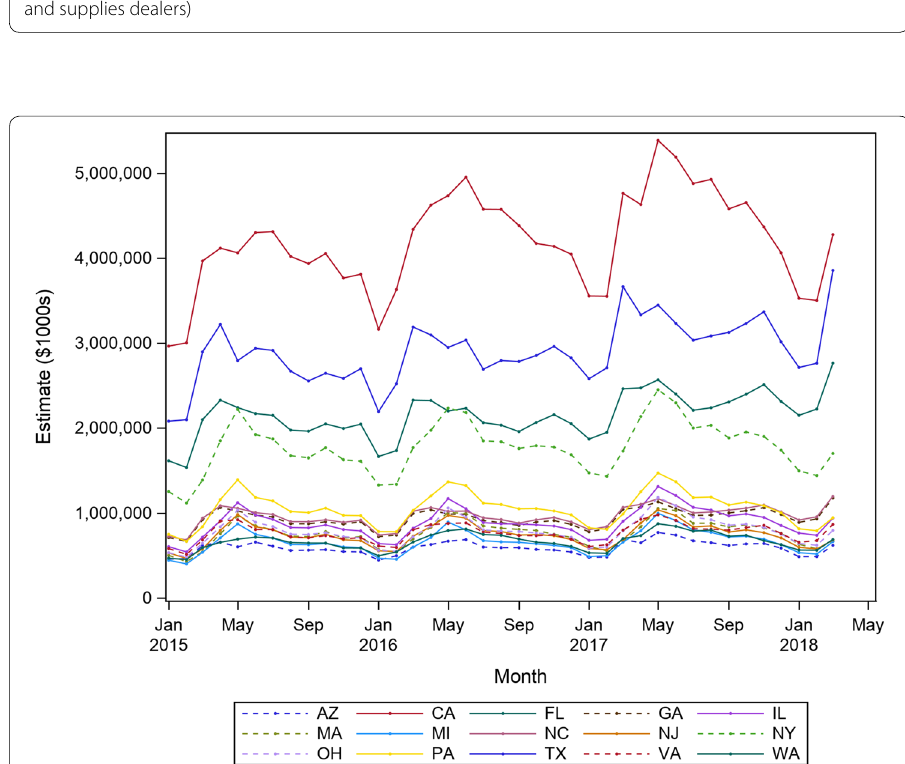
Fig. 7 State-level estimates of retail sales over time for NAICS 444 (building material and garden equipment and supplies